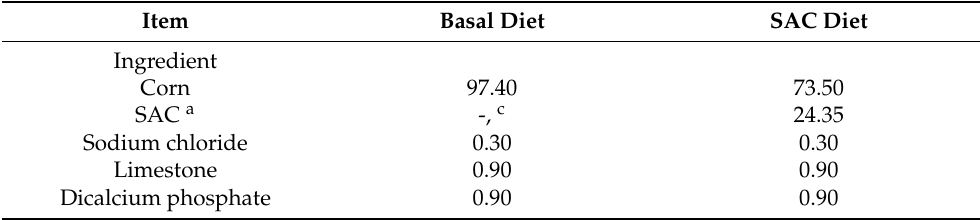
Table 2. Ingredients and analyzed nutrient levels of experimental diets used in Exp. 1 (%, as- fed